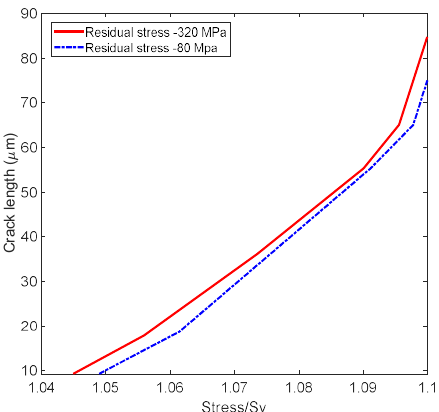
Figure 14. Crack length versus normalized stress with the nominal yield strength of the material with different values of residual stress ( −80 MPa and −320 MPa).